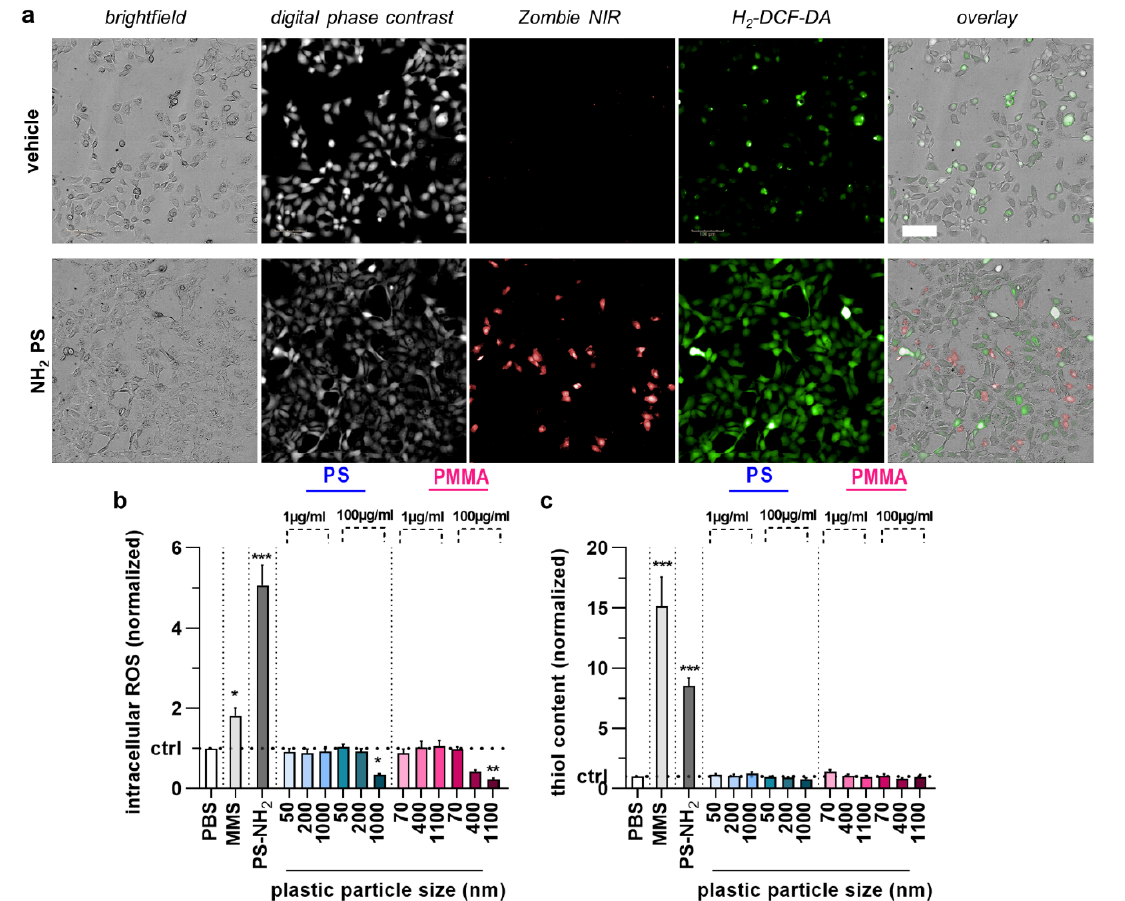
Figure 4. Cell cycle arrest, intracellular ROS, and antioxidant defense in HaCaT keratinocytes upon acute polymer particle exposure. ( a ) Representative brightfield, digital phase contrast, Zombie NIR, H2-DCF-DA, and overlay images of vehicle and NH 2 particle treated HaCaT keratinocytes; ( b , c ) intracellular ROS (normalized DCF mean fluorescence intensity) ( c ), and antioxidant defense (normalized thioltracker violet mean fluorescence intensity) ( c ) in HaCaT keratinocyte samples exposed to vehicle (PBS), MMS (positive control for genotoxicity), PS-NH 2 particles (positive control for polymer toxicity), and PS and PMMA polymer particles of different sizes (50–1100 nm) and concentrations (1 µg/mL and 100 µg/mL). Data are representative or mean + SEM from at least four independent experiments. Statistical analysis was performed using one-way analysis of variances with Dunnett post hoc testing for multiple comparisons with * = p < 0.05, ** = p < 0.01, and *** = p < 0.001.